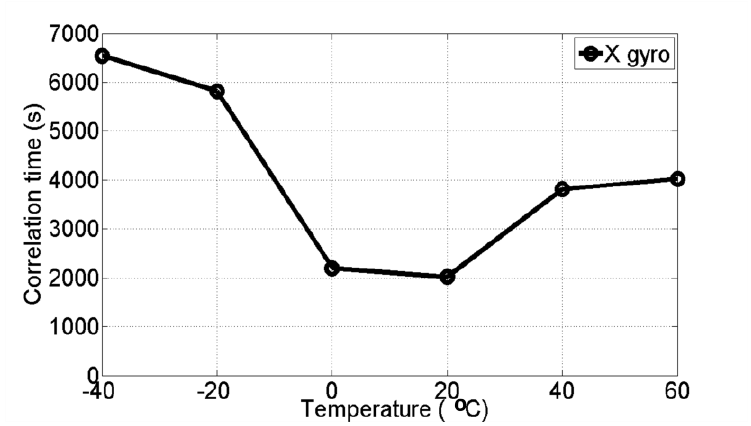
Figure 8. Correlation times for the three different gyros (X gyro, Y gyro, and Z gyro) at different temperature